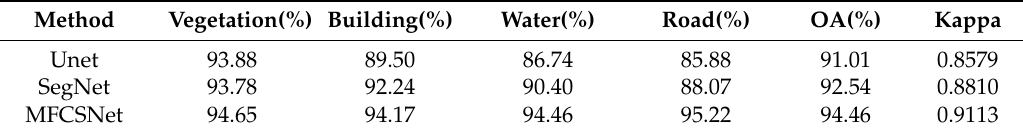
Table 2. Accuracy, overall accuracy and Kappa coe ffi cient of experimental